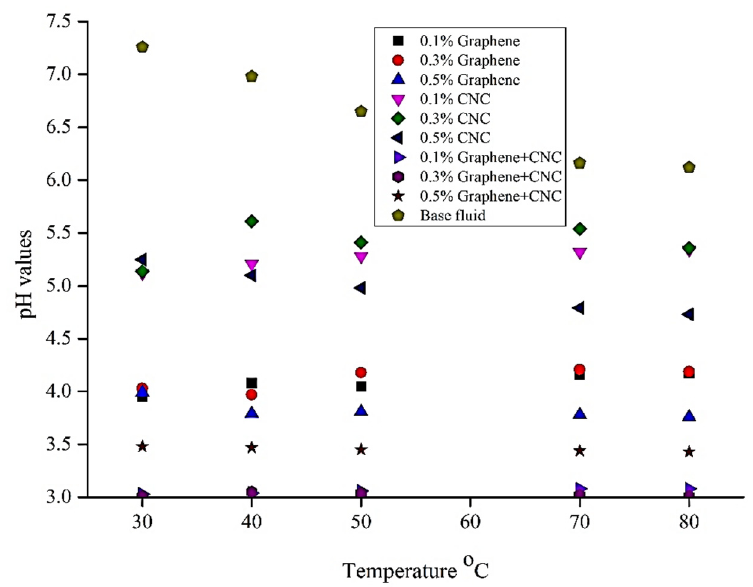
Figure 18. A pH of different concentrations of graphene, CNC nanofluids, and hybrid nanofluids.